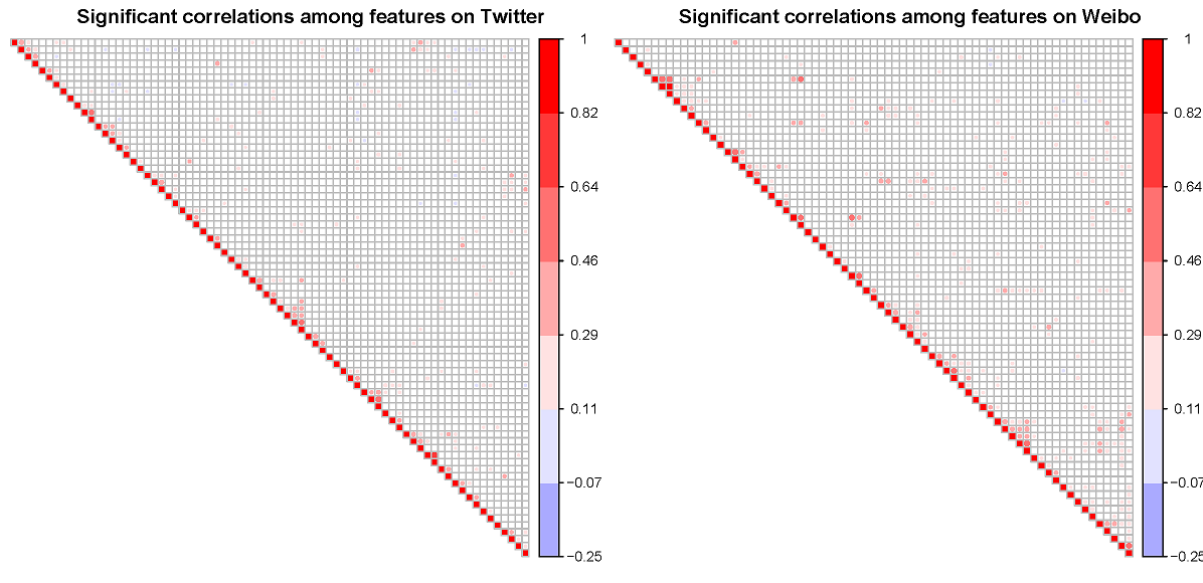
Figure 3. Significant Pearson correlations ( P <.05) among content features on Twitter (left) and Weibo (right). The complete list of the 77 content features on the x- and y-axes can be found in Multimedia Appendix